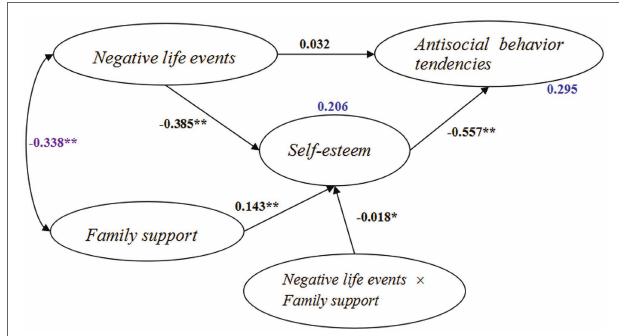
FIGURE 3 | The moderated mediation model. (Standardized coefficients are presented here. Paths of the control variables are omitted for clarity. * p < 0.05, ** p < 0.01).